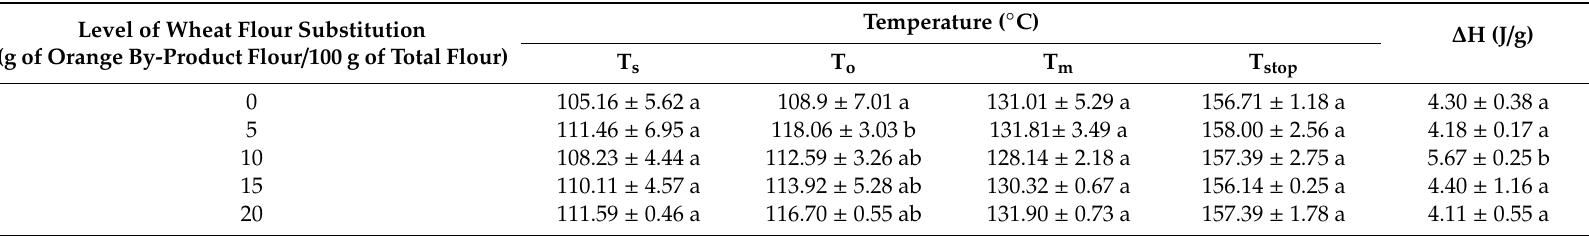
Table 5. Mean values obtained from the transition temperatures (Ts, start temperature; T o , onset temperature; T m , maximum temperature; and T stop , final temperature) and the enthalpy of the cookie with di ff erent concentrations of orange by-product flour